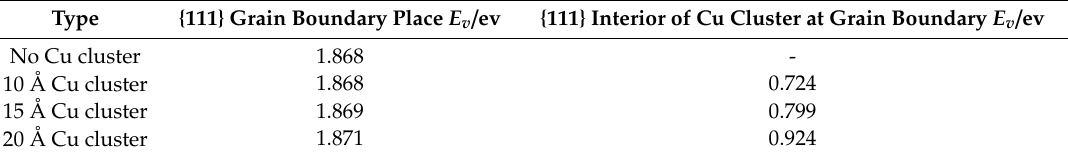
Figure 4. Stress–strain diagram of {111} grain boundary with no Cu clusters and with Cu clusters of di ff erent sizes. Table 2. {111} E v with and without Cu clusters at grain